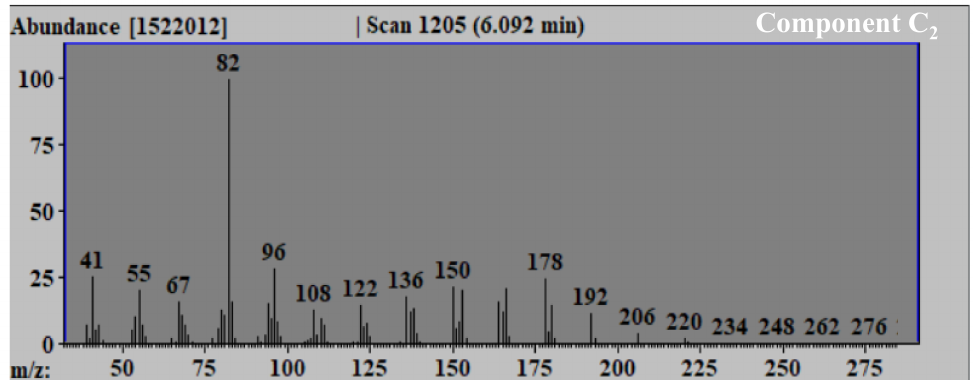
Figure A1. ion spectrum of the C 2 component in the hexane wash of the foragers (ant_ref_4) obtained by GC-MS analysis.